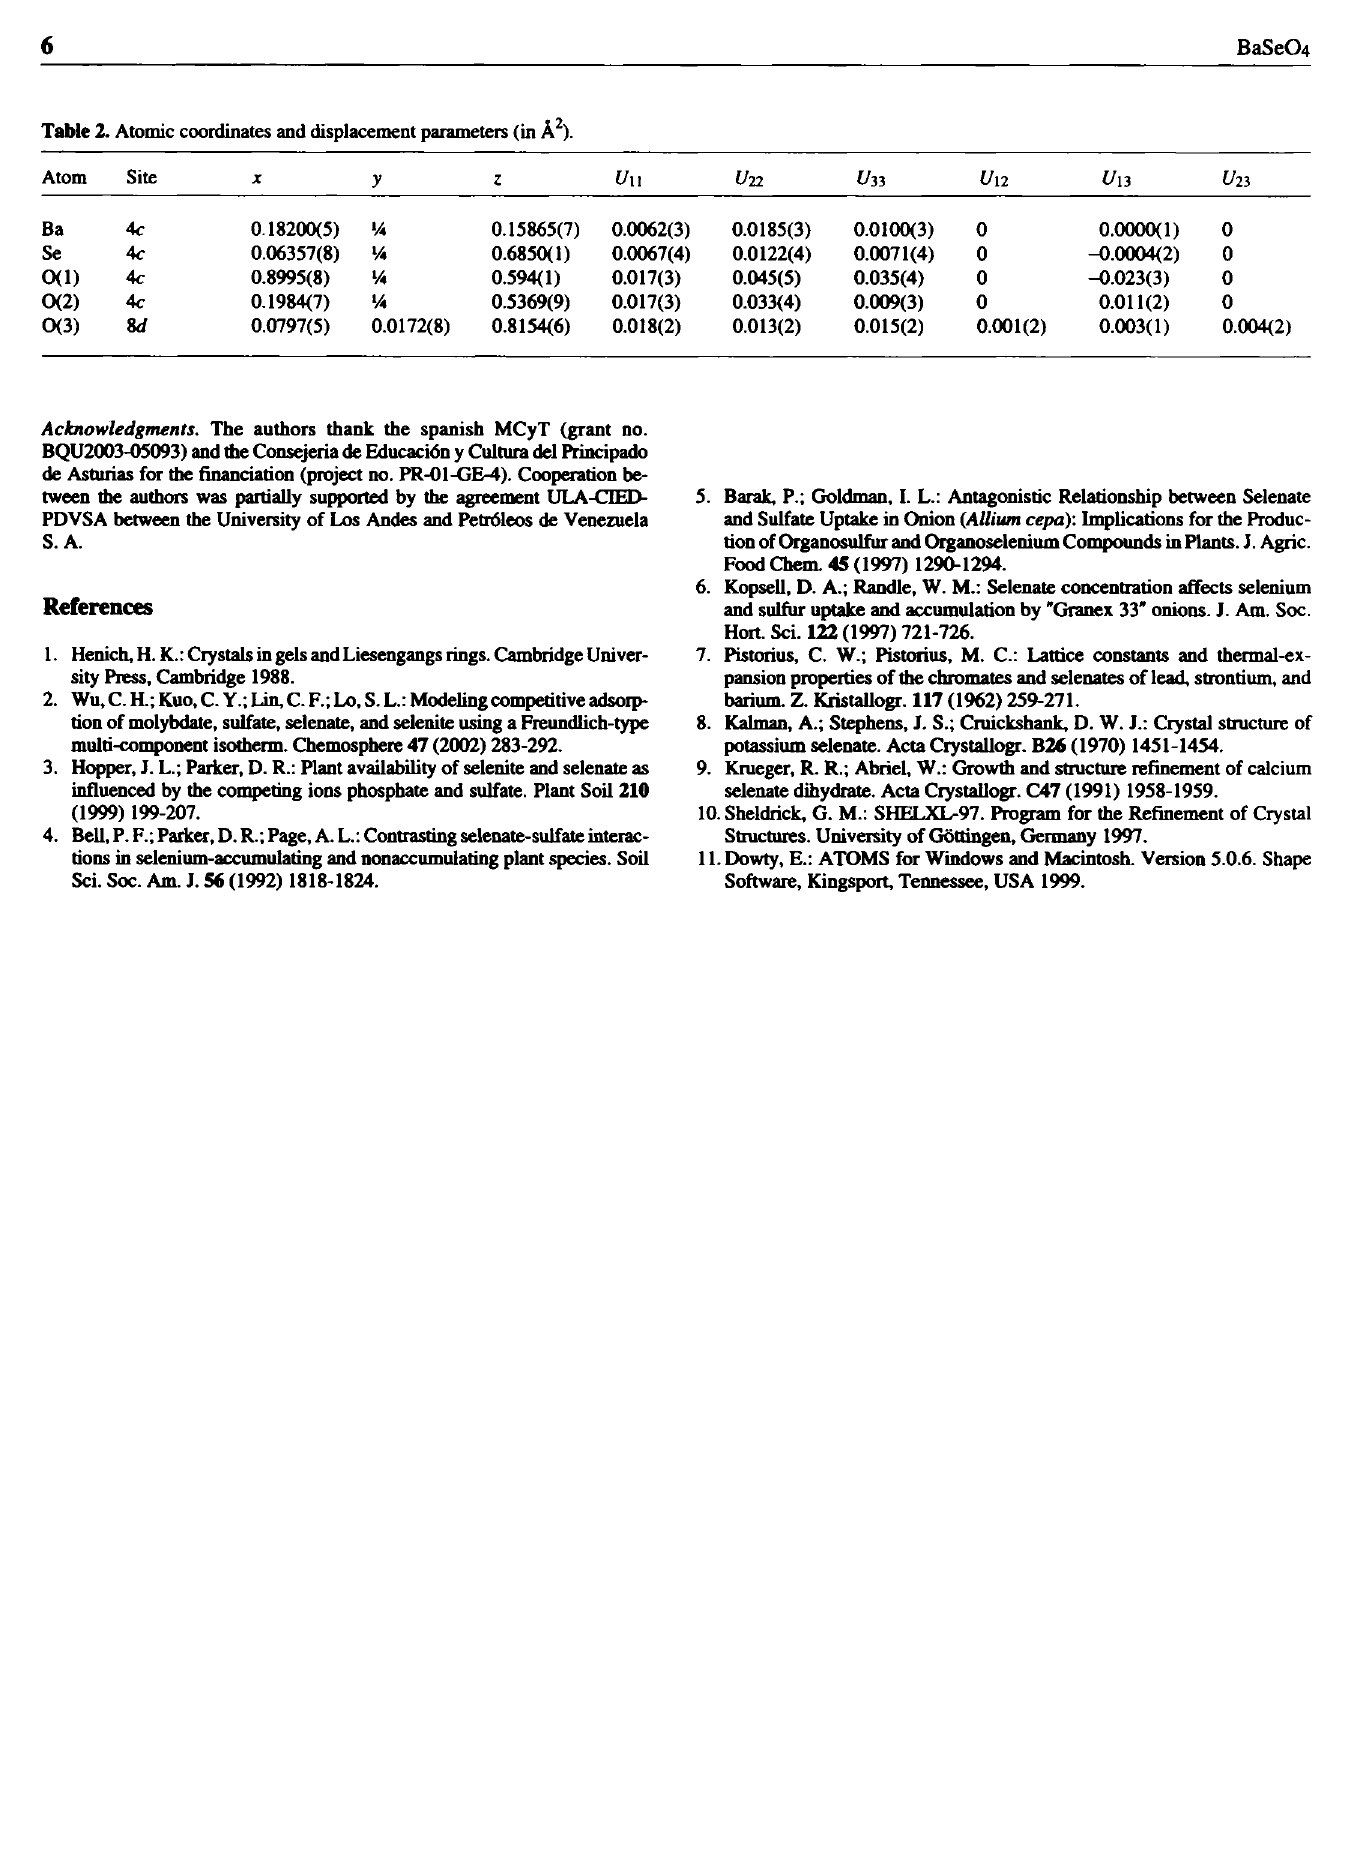
Table 2. Atomic coordinates and displacement parameters (in Ä 2